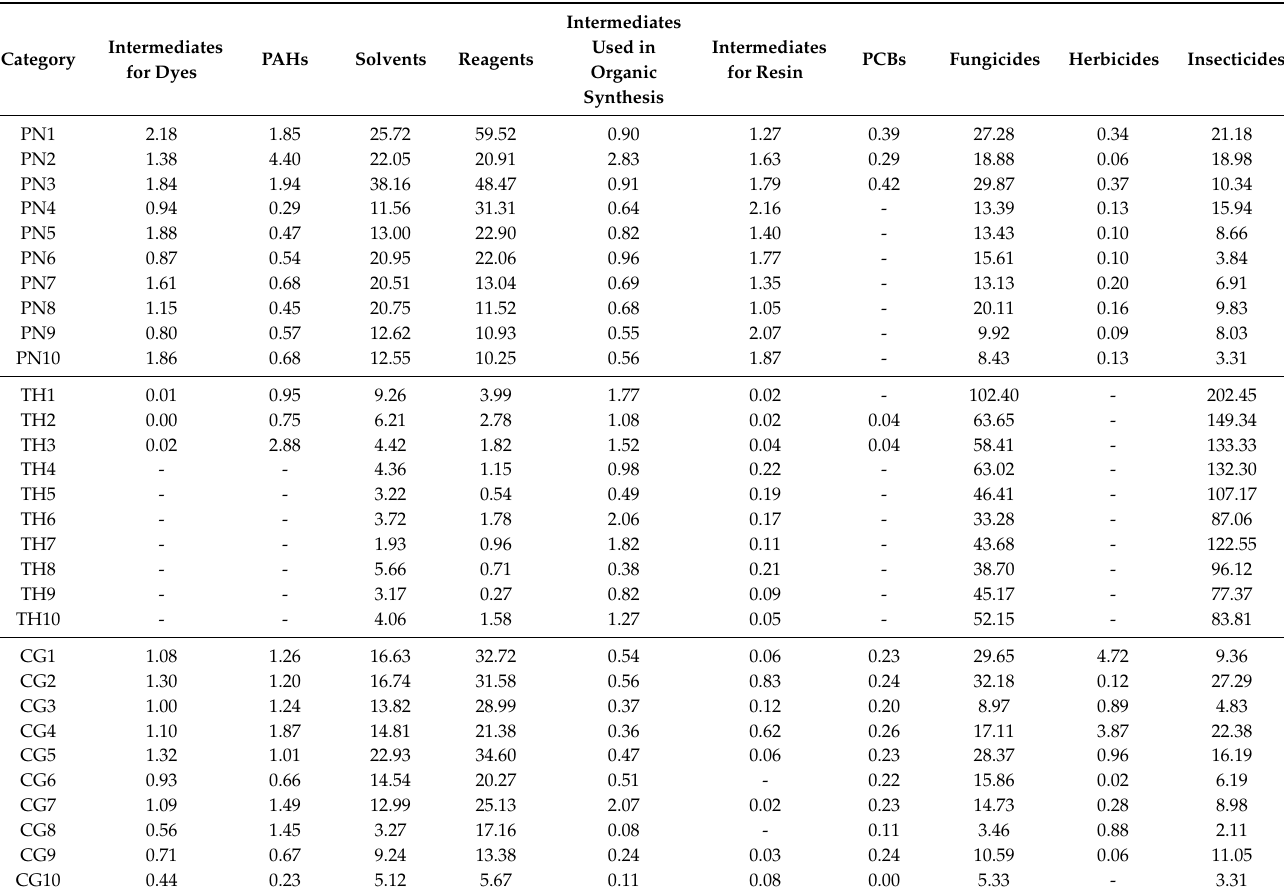
Table 1. The concentration of trace organic compounds derived from industry and agriculture (ng.m − 3